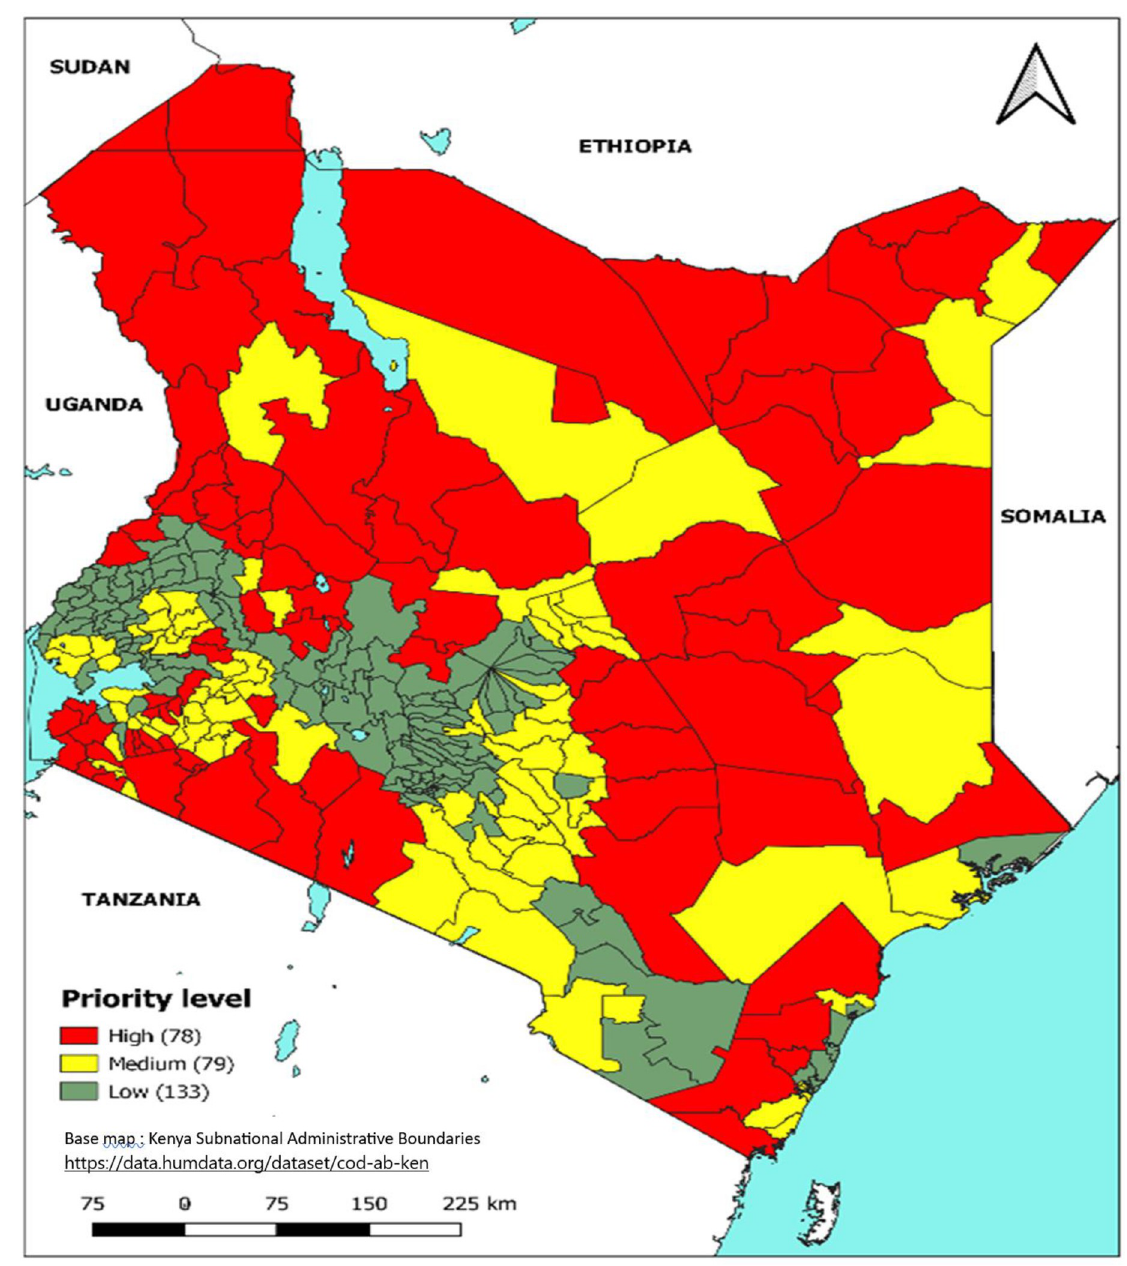
Fig 5. Priority sub-counties based on WASH indicators, Kenya, 2015–2019. Link to base map layer: https://data.humdata.org/dataset/ cod-ab-ken Link to terms of use: https://data.humdata.org/faqs/licenses.